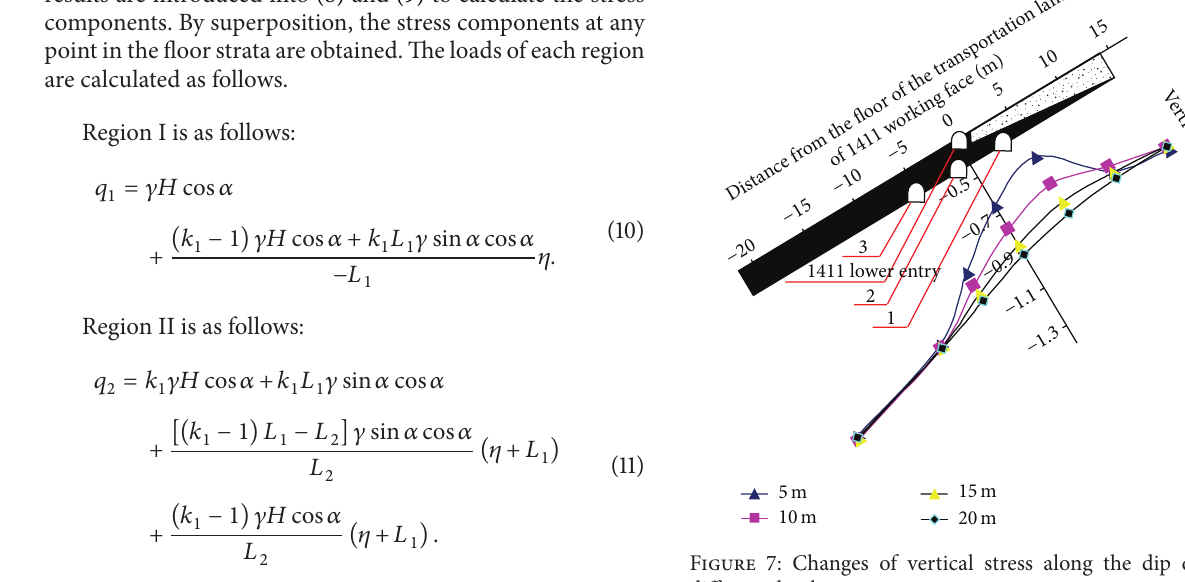
Figure 7: Changes of vertical stress along the dip direction at different